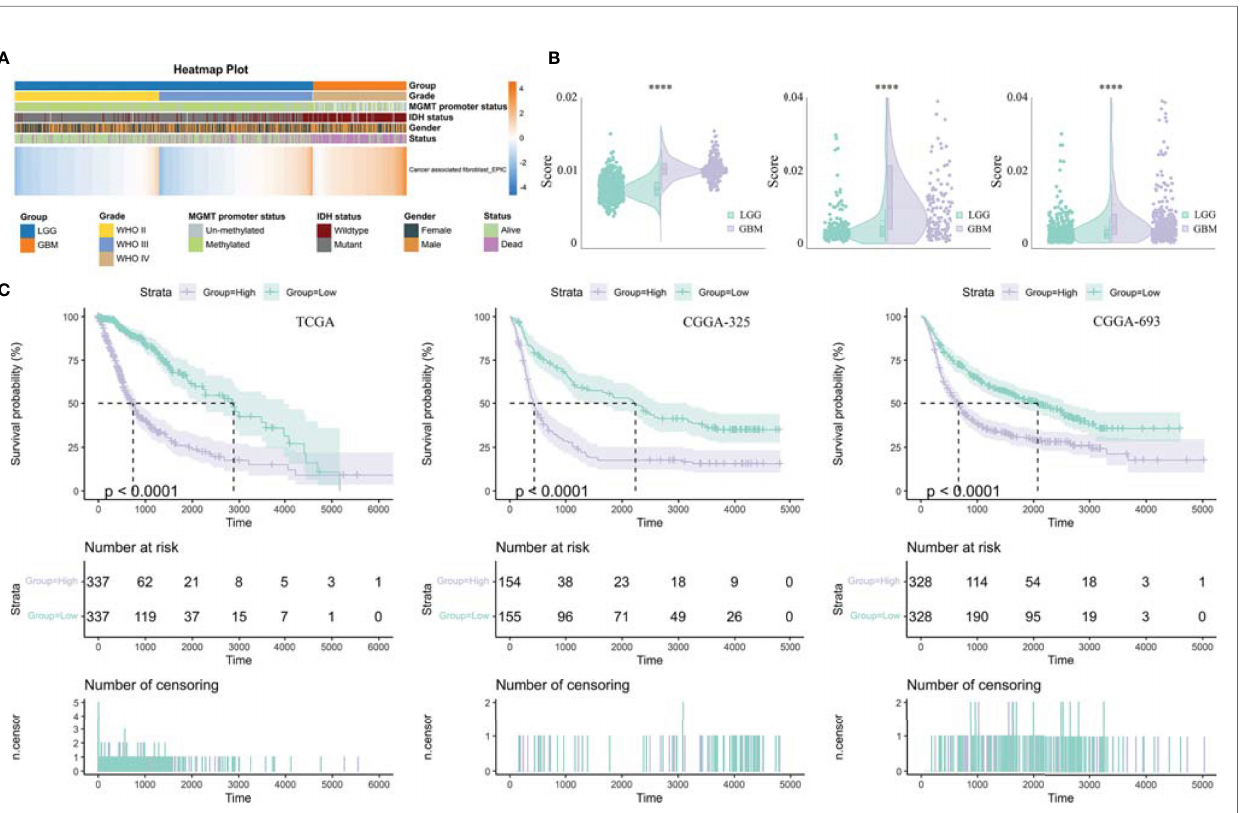
FIGURE 2 | Analysis of tumor-in fi ltrating fi broblasts in glioma. (A) Heatmap was drawn to depict the TAF in fi ltration in glioma from TCGA GBMLGG cohort. (B) TAFs were increased in GBM relative to LGG in TCGA GBMLGG cohort, CGGA #325 cohort, and CGGA #693 cohort, respectively. (C) Kaplan – Meier curves displayed that increased TAF in fi ltration was associated with poor prognosis and lower survival rate of glioma. ****, p <